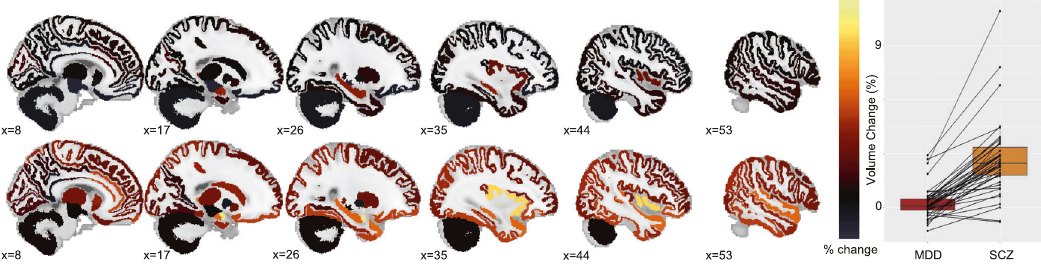
Fig. 2 Volume changes across the cortical and subcortical areas. Lower panel: each dot corresponds to one of the 42 regions (for a comprehensive list see Supplementary Tables 2 and 3), similar regions are connected. Color bar represents the average percentage